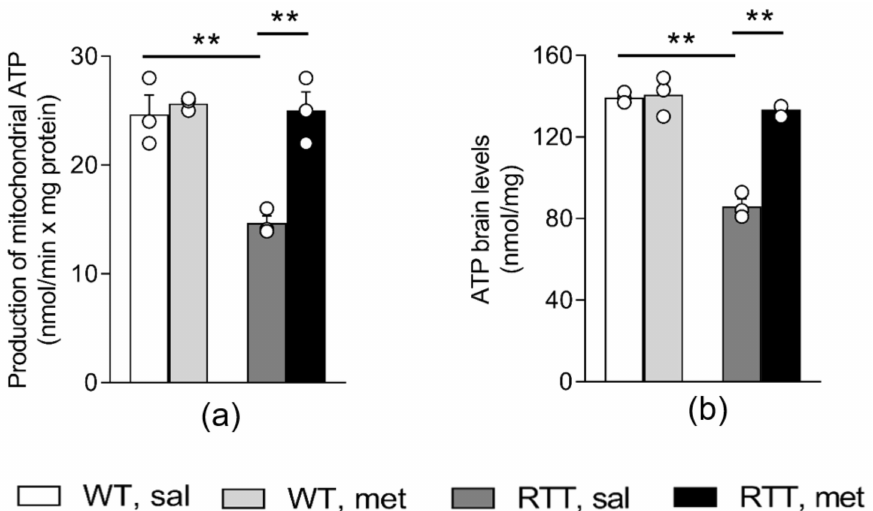
Figure 1. Metformin systemic treatment rescues defective energy status in RTT mouse brain. A 10-day long treatment with metformin (100 mg / kg) completely normalizes the reduced mitochondrial ATP production via oxidative phosphorylation ( a ) and ATP levels ( b ) in RTT mouse brain. N = 3. Data are mean ± SEM. Statistical significance was calculated by two-way ANOVA, with Tukey’s post hoc test. ** p < 0.01. WT: wild-type mice; RTT: MeCP2-308 heterozygous female mice; sal: saline; met: